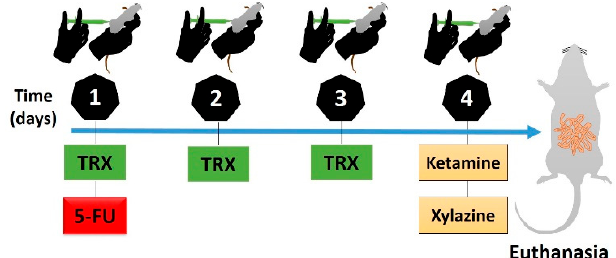
Figure 11. Scheme of induction and treatment of intestinal mucositis. TRX: troxerutin (day 1: 50 mg / kg; day 2: 100 mg / kg; day 3: 10 mg / kg); 5-FU: 5-Fluorouracil (day 1: 450 mg / kg, one hour after TRX); ketamine and xylazine (day 4: 270 and 15 mg / kg, respectively).